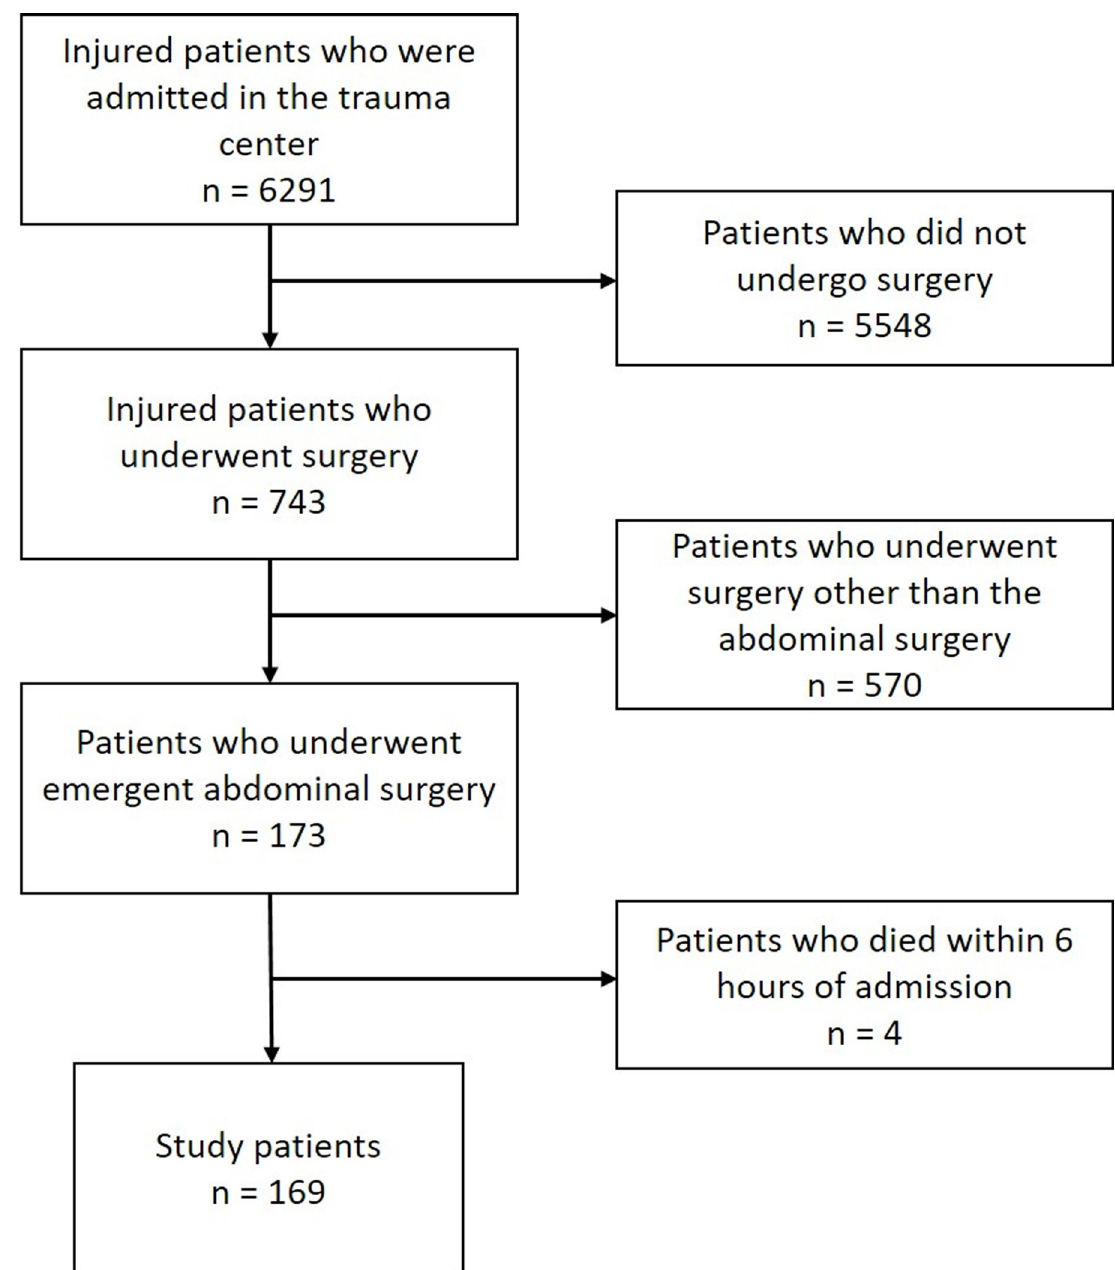
Fig 1. Patient flow